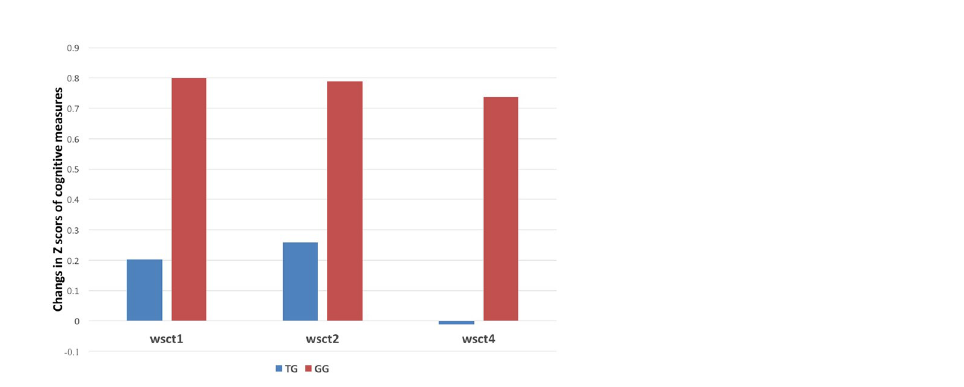
Table 2. The impact of rs10466907 genotypes on cognitive recovery after six weeks of treatment. Note: CI: confidence interval.